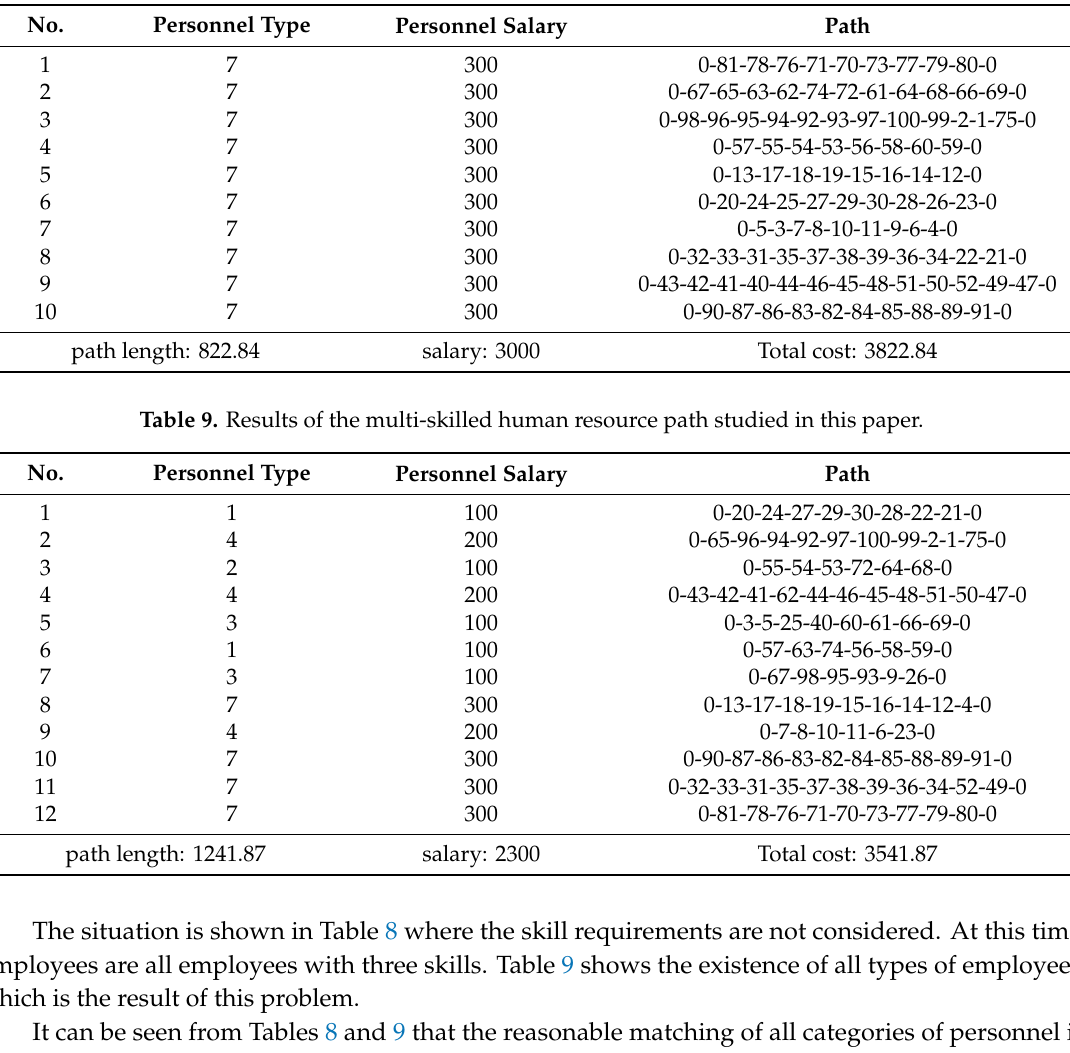
Table 8. Results in the traditional path problem without considering skill requirements.